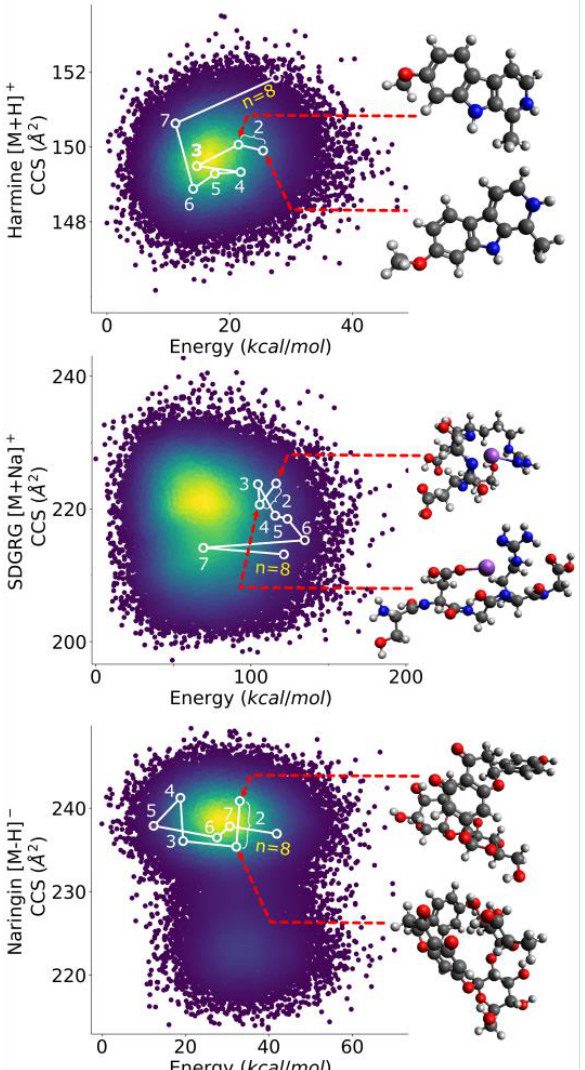
Figure 1. Demonstration of SDS choosing the 8 most mutually dissimilar conformers for Harmine [M+H] + , SDGRG [M+Na] + , and Naringin [M − H] − , showing the structure of the three most dissimilar conformers for each. SDS works iteratively by finding the set n + 1 by building off the set n .